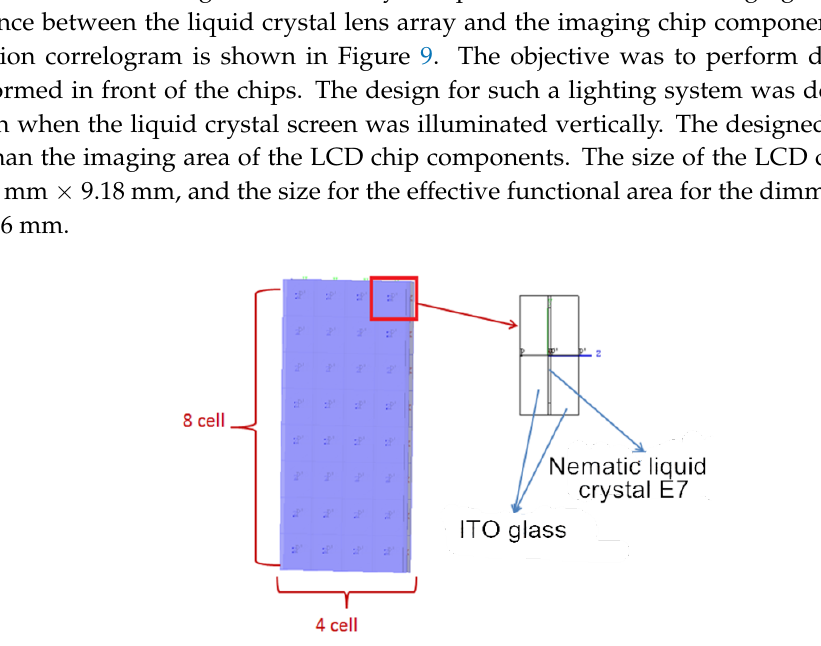
Figure 9. ( a ) A top view of the liquid crystal lenses ( b ) Elevation diagram for liquid crystal imaging lens array and LCD imaging components.